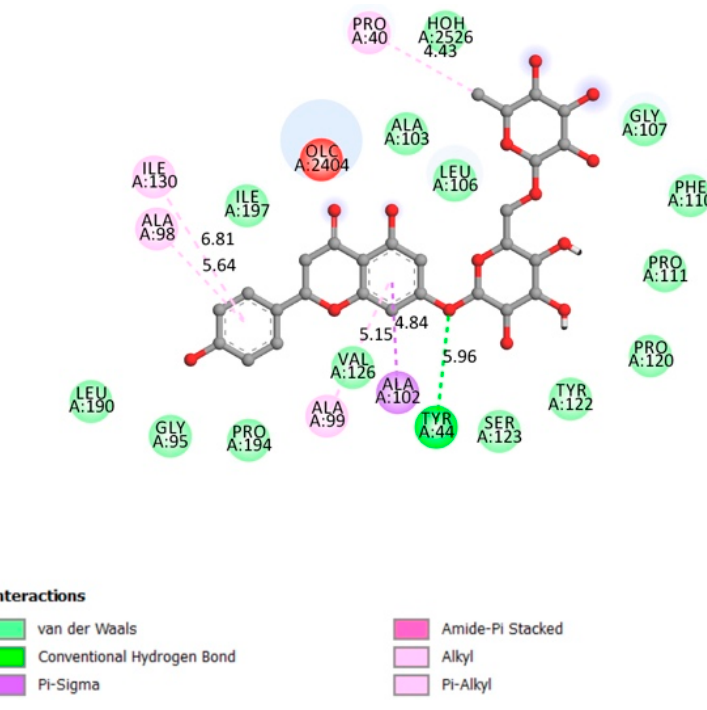
Figure 4. Two-dimensional scheme of the narirutin interactions with FFAR1.